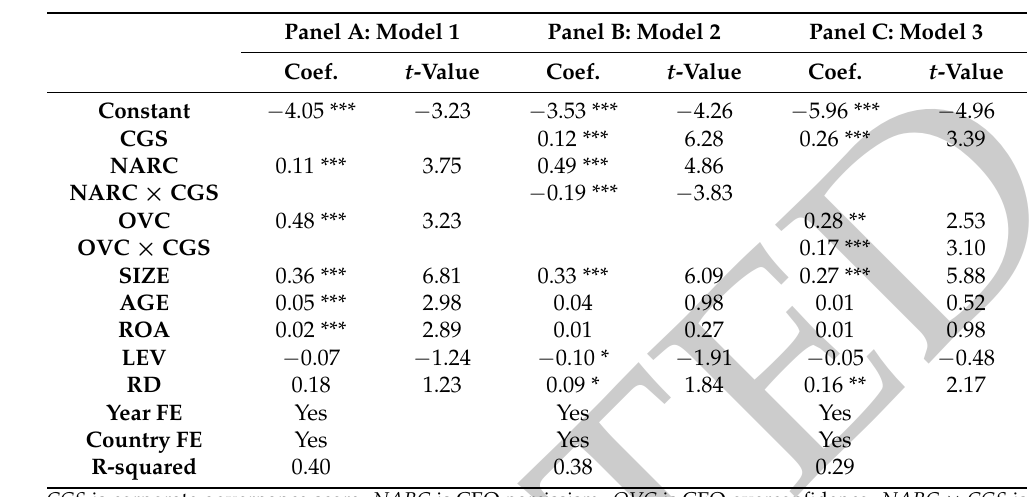
Table 7. First robustness test (#Obs. 280).